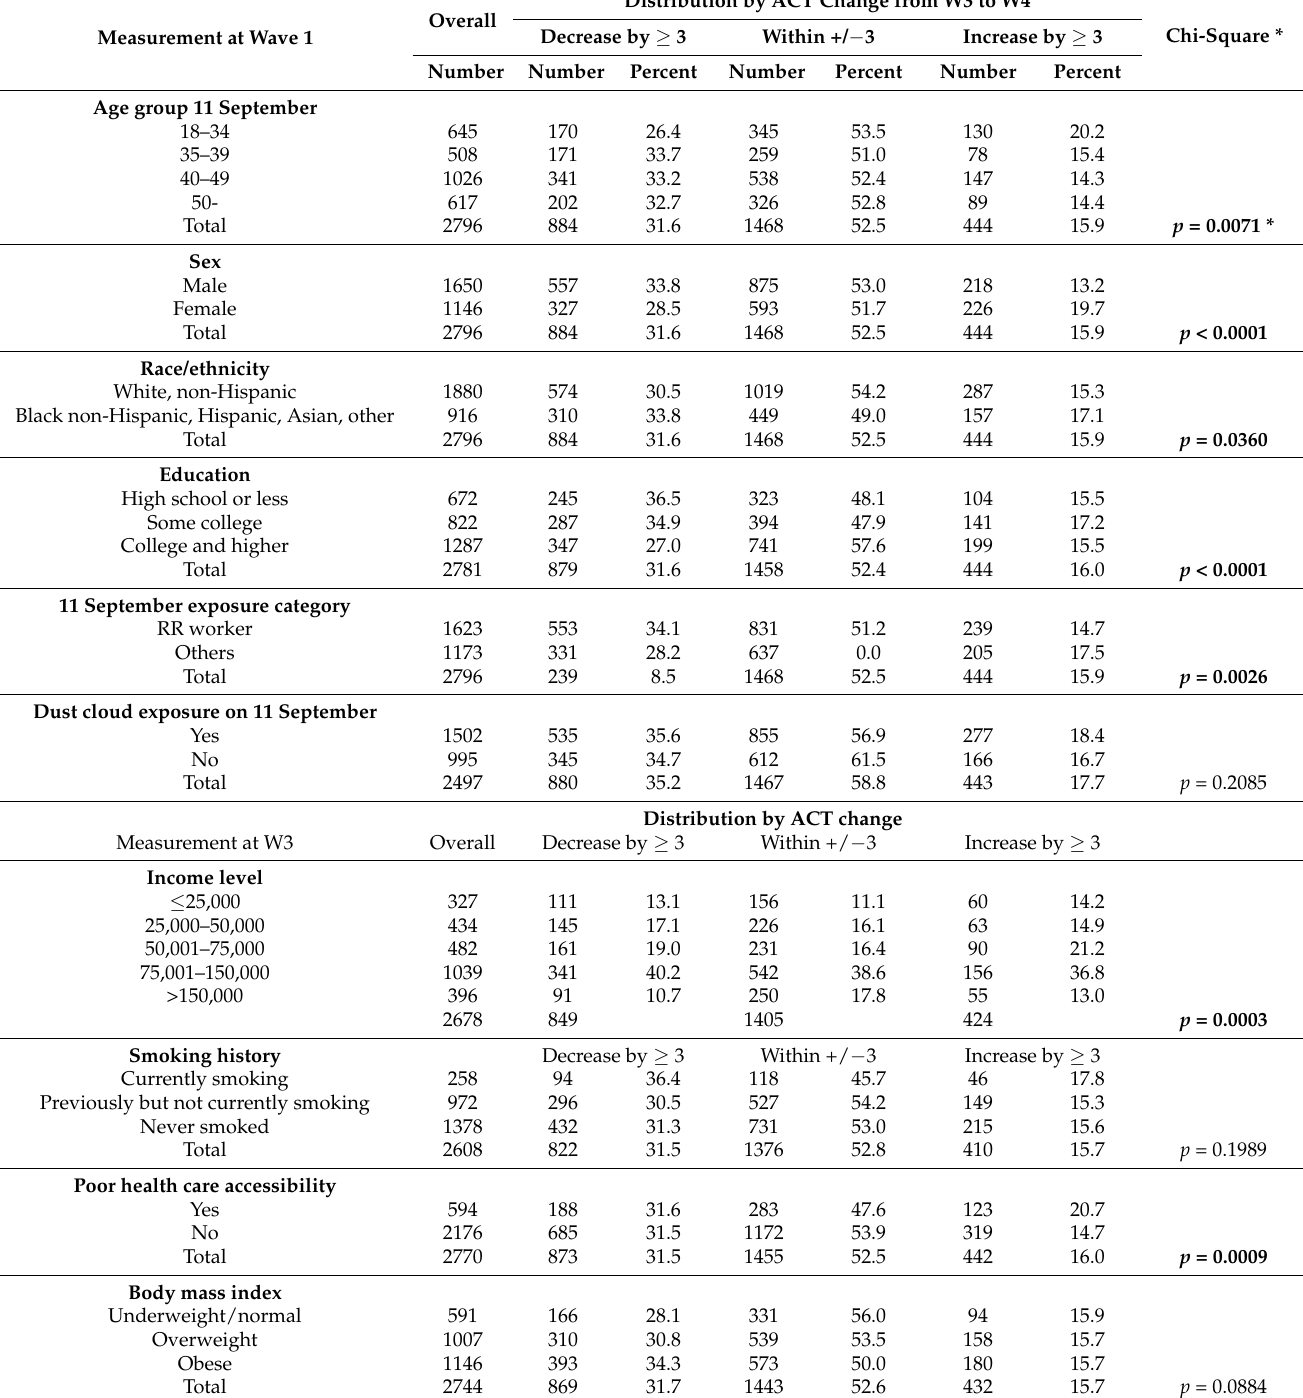
Table 2. Demographics, exposures and other relevant factors’ effect on change in ACT